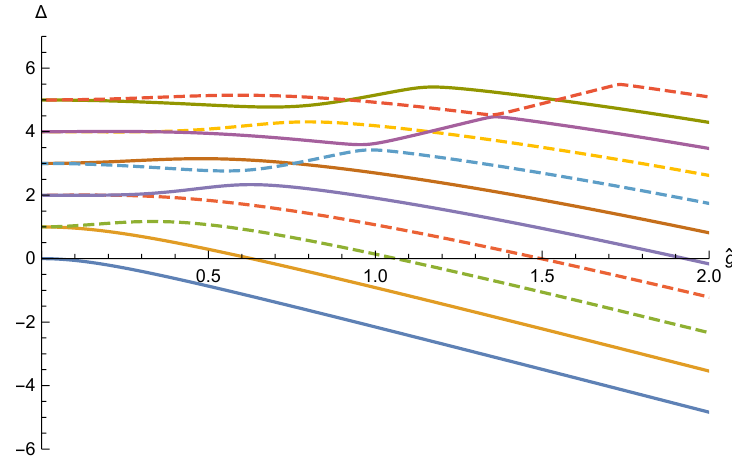
Figure 13 . The (cid:12)rst few states for (cid:30) = 1 : 5 . We show numerical data for (cid:1) as a function of ^ g , obtained from the Baxter equation. We see that all the states, except the ground state, are paired together at weak coupling.